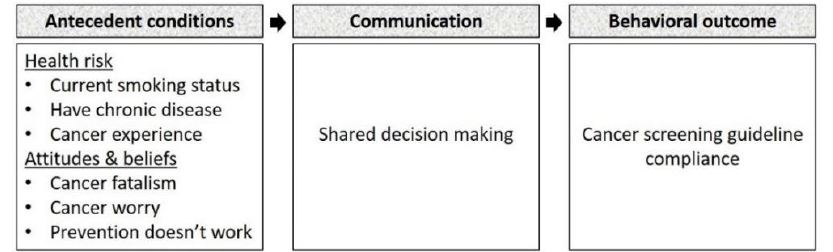
Figure 1. Conceptual framework.